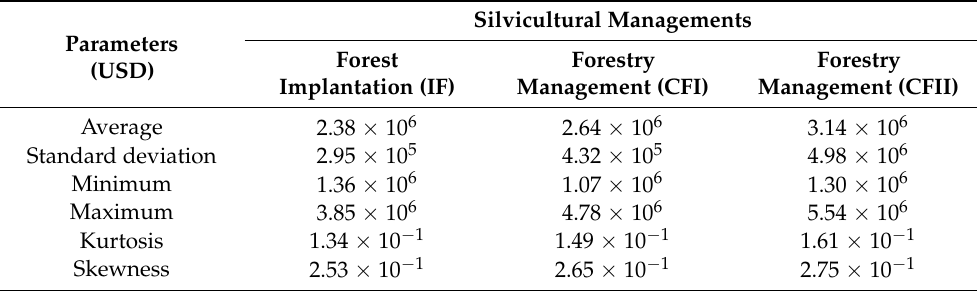
Table 2. Descriptive statistics of Monte Carlo simulation for investment projects of three consecutive rotations, with Eucalyptus wood price following fractional Brownian